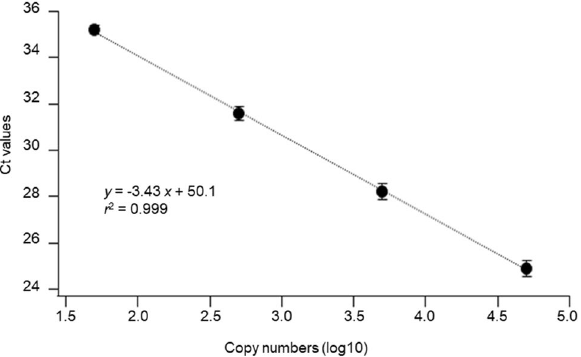
Figure 2. Standard curve for relations between Ct values and copy numbers. Error bars indicate SD. Ct cycle threshold, SD standard